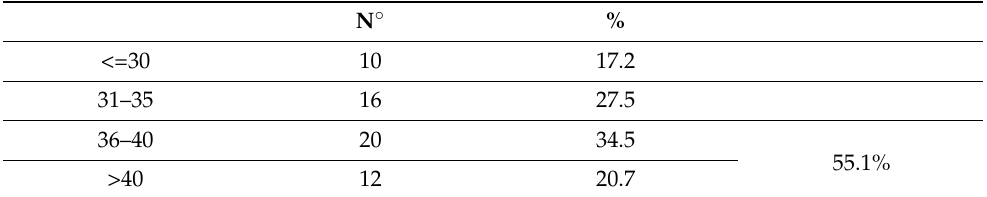
Table 6. Maternal Age.